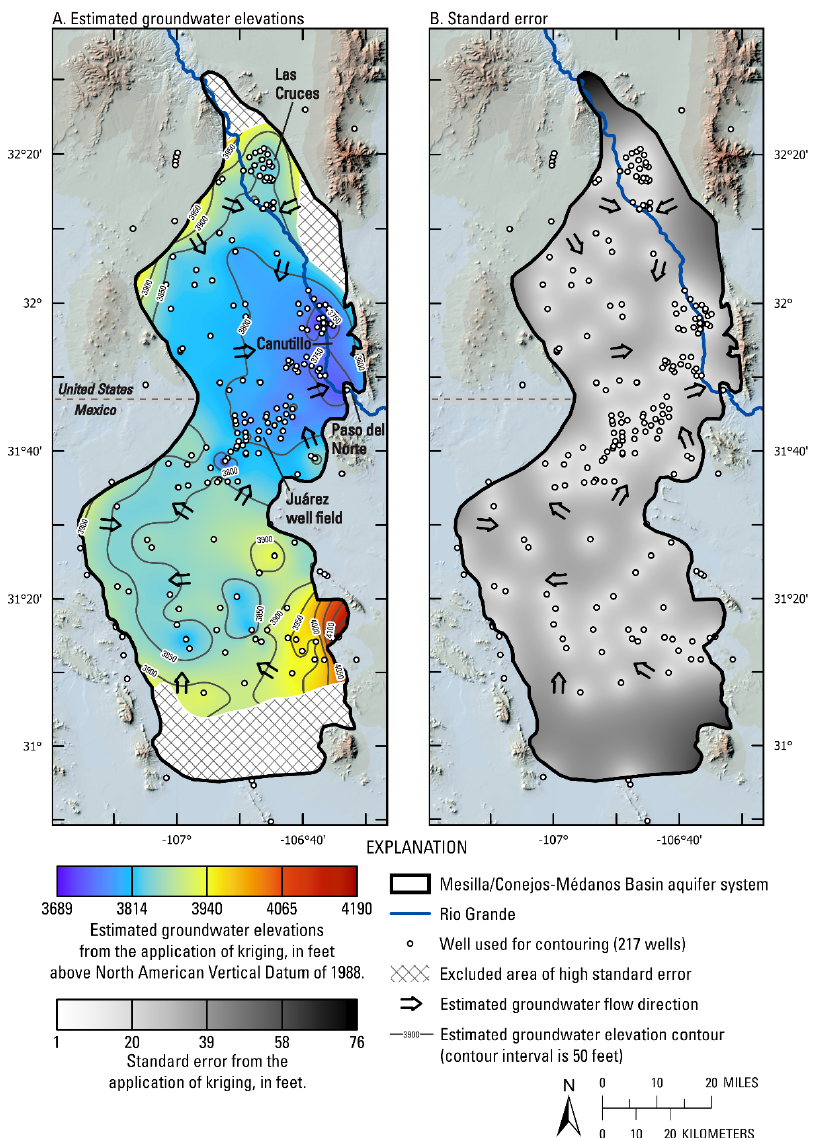
Figure 5. Estimated groundwater elevations ( A ) and standard error values ( B ) from application of kriging in the Mesilla/Conejos Médanos Basin [23]. Base terrain and geographic references are from [5,6,34]. Coordinates are the geographic coordinate system relative to the North American Datum of 1983.